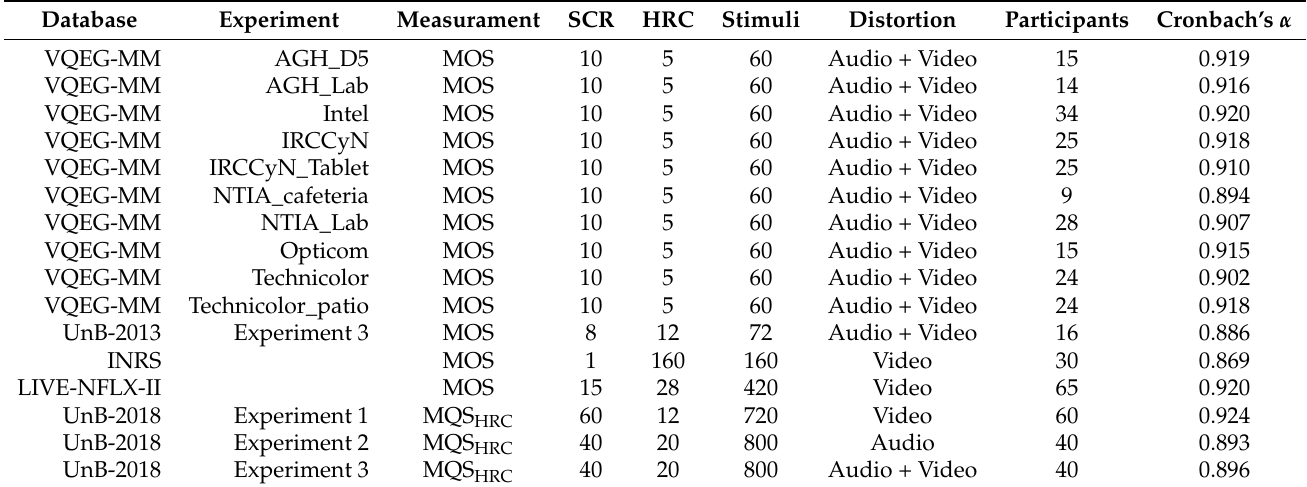
Table 14. Comparison of the Cronbach’s α of all three experiments and other available audio-visual databases.